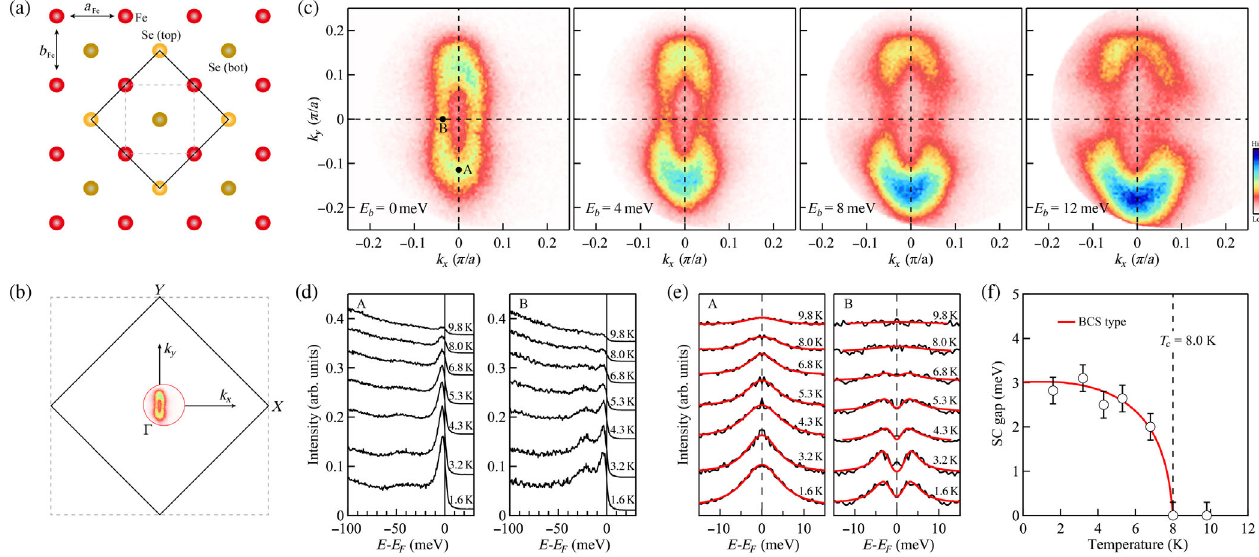
FIG. 1. Fermi surface of the single domain FeSe measured at 1.6 K around the Γ point and its superconducting gap. (a) Top view of FeSe crystal structure. The red, yellow, and gray circles represent Fe atom, Se atom above the Fe plane (Se top), and Se atom below the plane (Se bottom), respectively. The dashed line represents the 1-Fe unit cell while the solid line represents the 2-Fe unit cell. We define x axis parallel to a ¼ b axis and y axis parallel to b axis. In the normal state, FeSe has C 4 symmetry with a , but it breaks into C 2 Fe Fe Fe Fe > b symmetry in the nematic state with a . (b) The Brillouin zone of FeSe. The dashed line and the solid line correspond to BZs of Fe Fe the 1-Fe unit cell and 2-Fe unit cell, respectively. The red circle represents the momentum area that can be measured simultaneously by our laser ARPES system with 6.994 eV photon energy. The whole Fermi surface of FeSe around the Γ point can be covered by one time measurement which occupies a very small portion of the BZ. (c) Constant energy contours around the Γ point at different binding energies measured at 1.6 K in LV polarization geometry. The measured Fermi surface (leftmost panel) shows an elliptical shape with its long axis along k y axis and short axis along k x axis. The spectral weight concentrates to the vertex areas and gets depleted around the central area with increasing binding energy. (d) Photoemission spectra (EDCs) measured at different temperatures for two typical Fermi momenta. The locations of the two momenta, A and B, are marked in (c) as black dots. (e) Corresponding symmetrized EDCs from (d). The curves are fitted with a phenomenological gap formula [41] (solid red curves). For point A (left-hand panel), no gap opening is detected below T c within our experimental resolution. Apparent gap opening occurs for point B (right-hand panel). (f) Temperature dependence of the superconducting gap at B point. It follows the BCS gap form (red